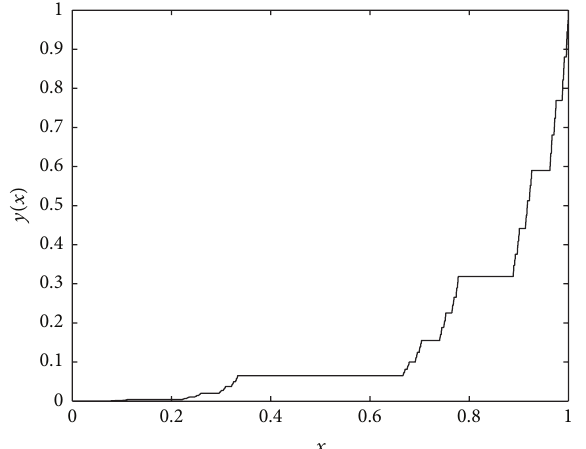
Figure 1: The ecological function 𝑓(𝑥) defined on Cantor